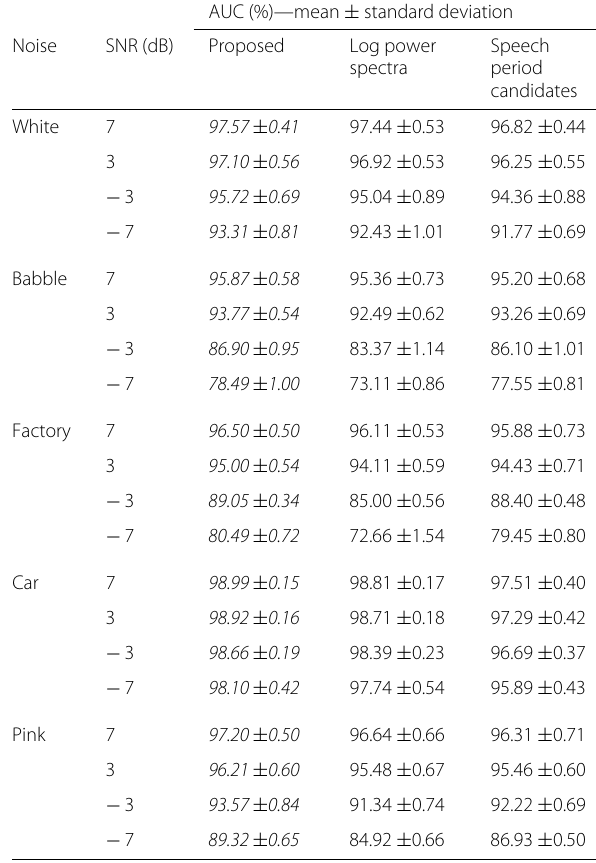
Table 2 AUC (%) comparison between the proposed method and DNN-based VAD methods using speech period candidates and log power spectra as the baseline for unknown